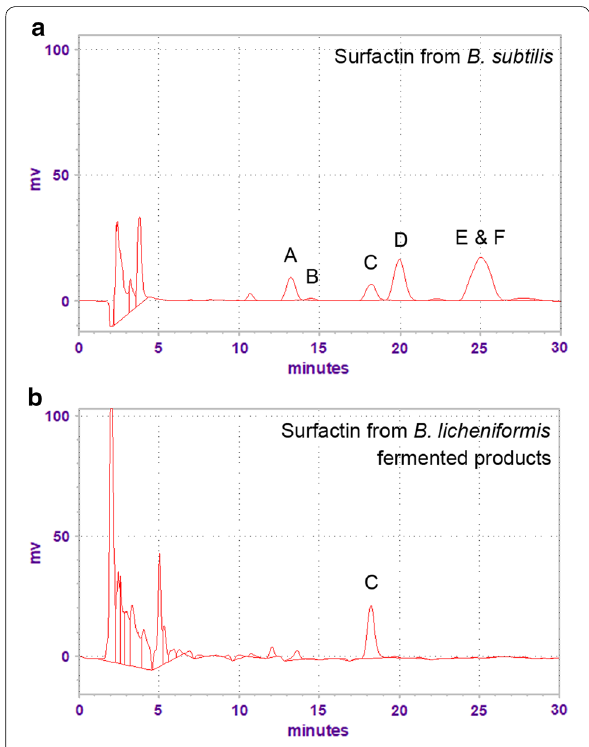
Fig. 1 HPLC chromatogram of surfactin. a The chromatographic peak of B. subtilis ‑derived surfactin and b B. licheniformis ‑fermented product‑derived